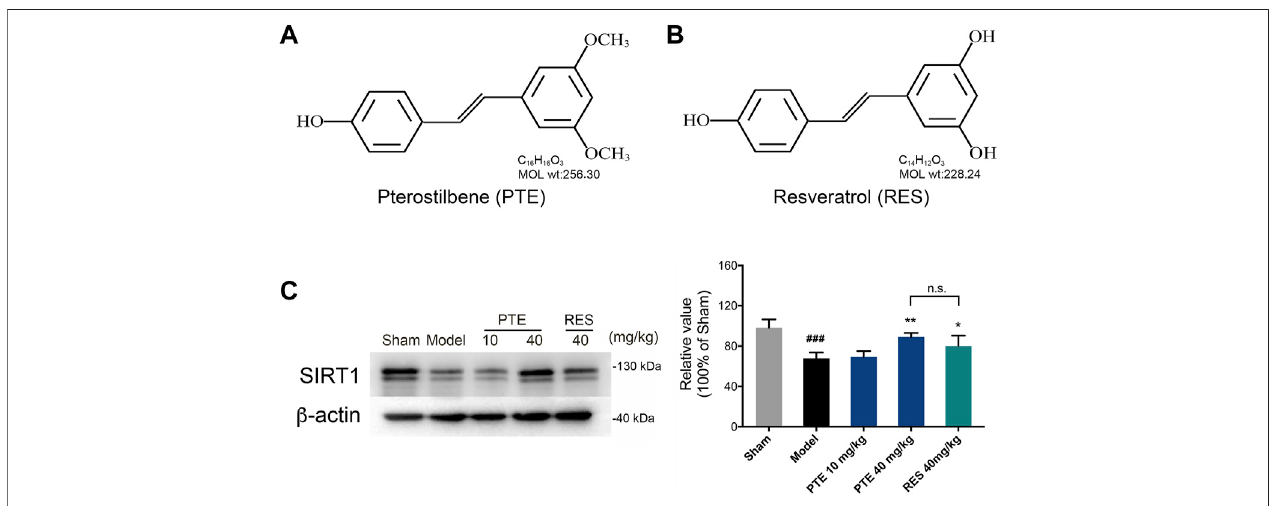
FIGURE 2 | Effects of PTE and RES on the expression of SIRT1 in AD mice. (A-B) Chemical structures of PTE (A) and RES (B) , respectively. (C) Western blotting band and quantitative analysis of SIRT1 in the cerebral cortex of mice. Data are shown as mean ± SD (n = 3 – 4). ### p < 0.001 vs sham; * p < 0.05, ** p < 0.01 vs model.